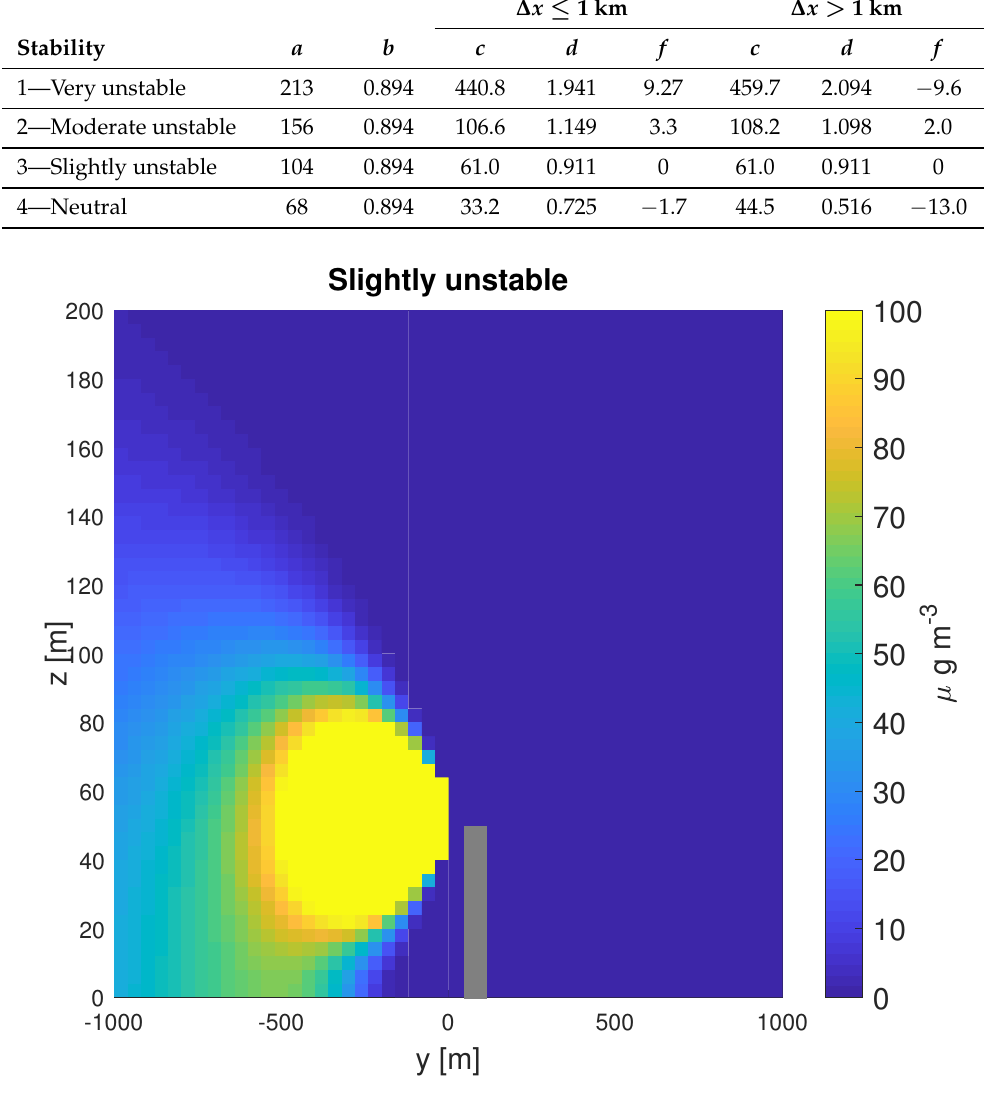
Figure 5. The 2D Gaussian pollutant concentration dispersion model in a plume for the slightly stable situation. The gray bar represents the effective height of the emission